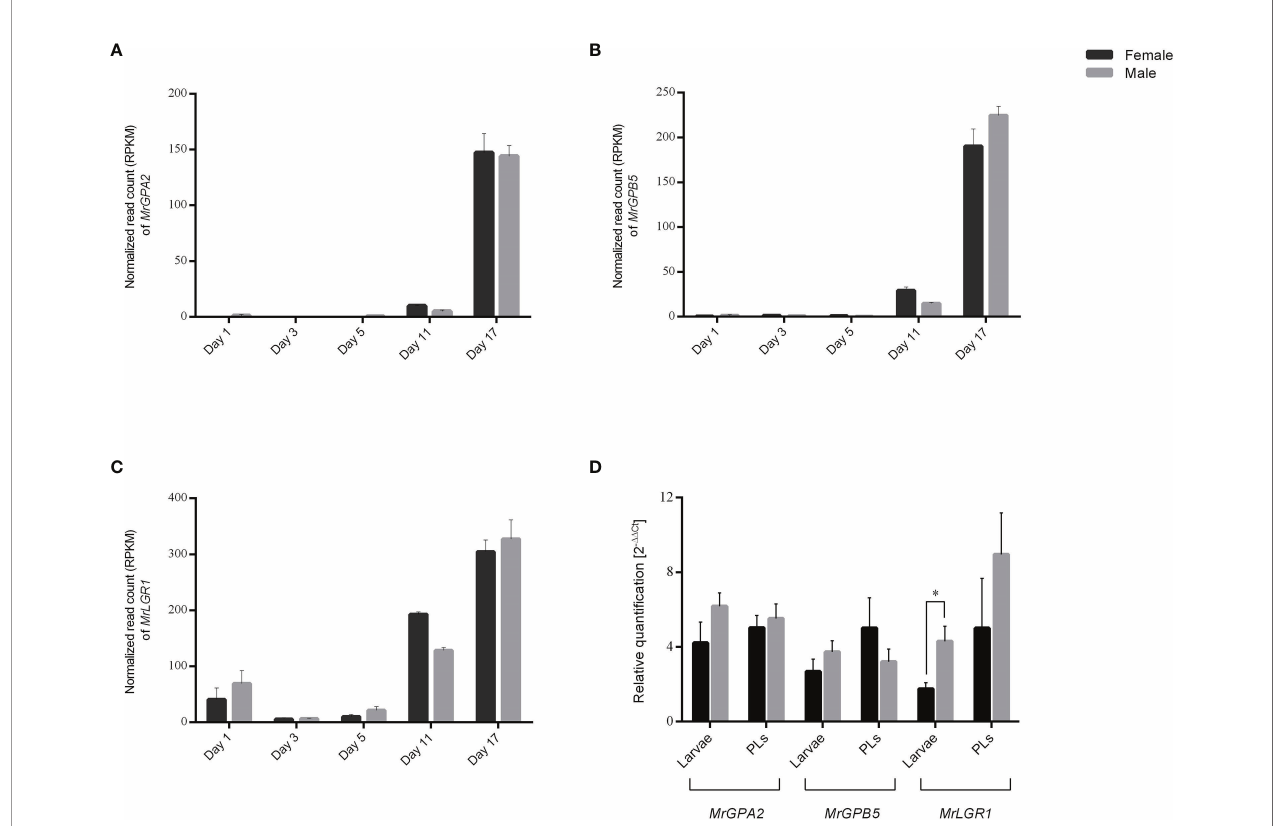
FIGURE 3 | In silico and in vitro temporal expression patterns. (A – C) In-silico temporal expression patterns in M. rosenbergii embryonic stages for (A) MrGPA2 , (B) MrGPB5 and (C) MrLGR1 . The number of mapped reads per sample (i.e., day 1, day 3, day 5, day 11 and day 17 in males and females) was normalized by reads per kilobase of transcript per million mapped reads (RPKM), dividing it by the total number of reads from that sample and multiplied by 1 × 10 6 . (D) In-vitro temporal expression patterns. Relative quanti fi cation of MrGPA2 , MrGPB5 , and MrLGR1 in male and female larvae and post-larvae (PLs). Asterisks represent the statistically signi fi cant differences ( P < 0.05, t